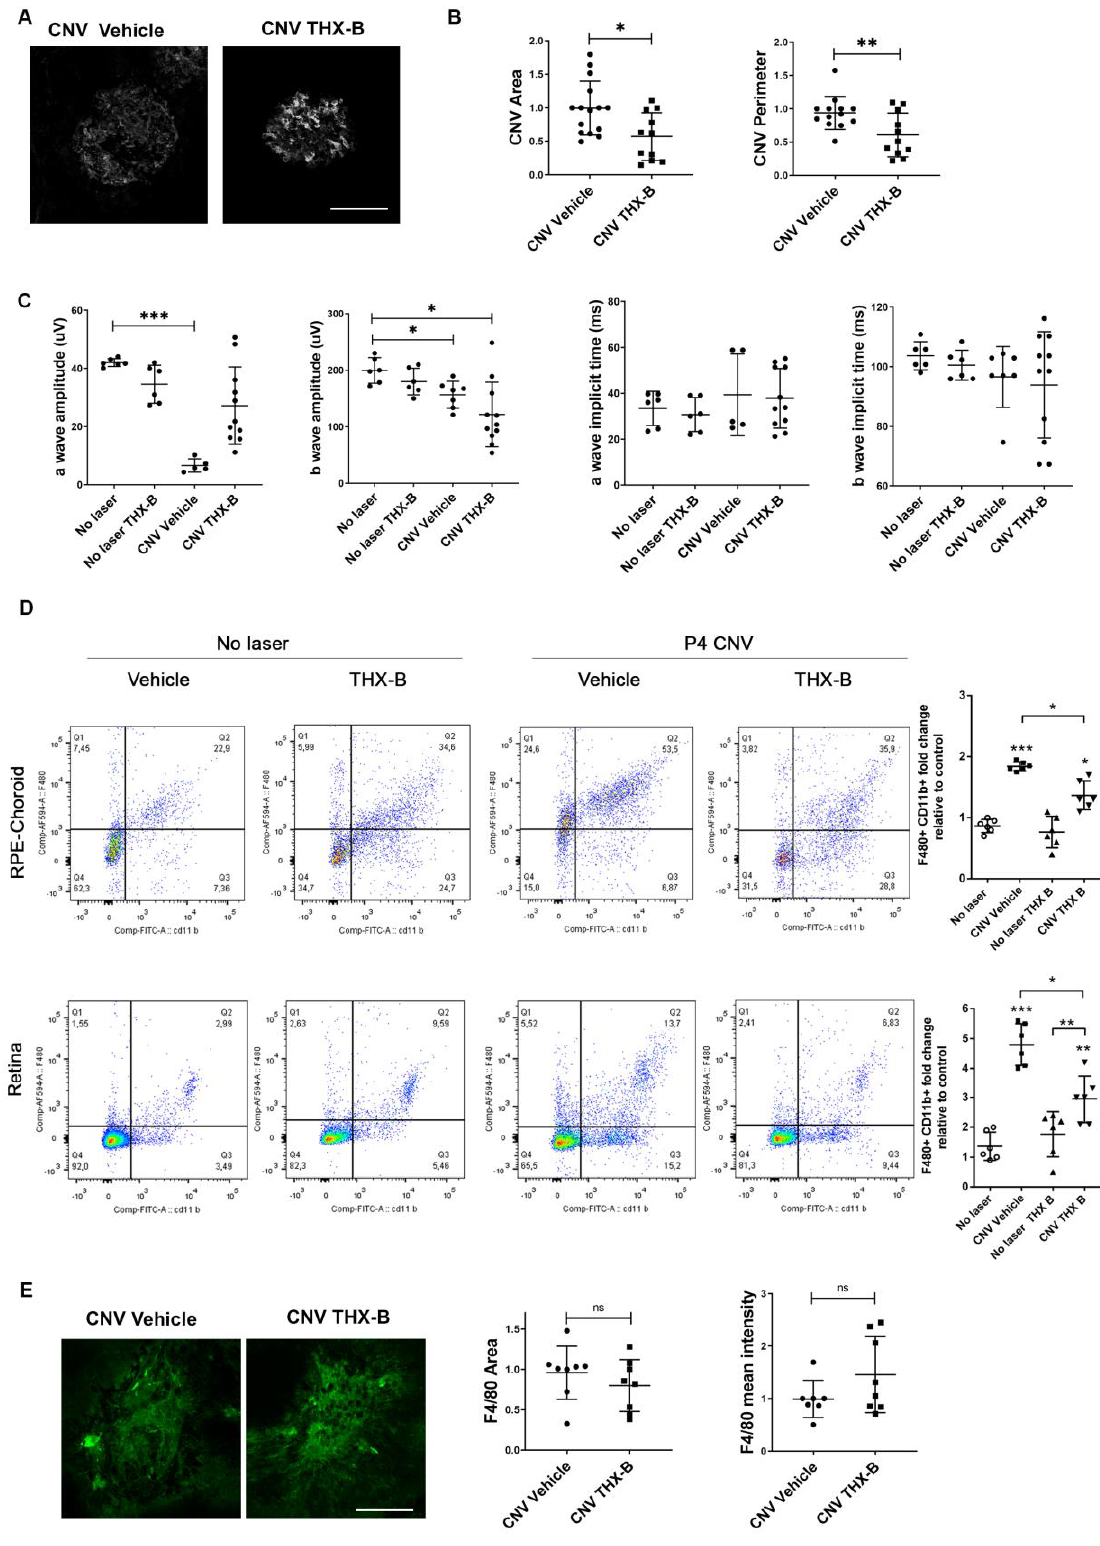
Figure 5. Reduced neovascular phenotype and improved retinal function in p75 NTR antagonist- treated wild type mice after laser injury. p75 NTR receptor antagonist reduced the area and perimeter of choroidal neovessels and improved retinal functionality in WT CNV mice. ( A ) Representative confocal images of RPE-Choroid flat-mounts of WT mice 7 days after laser, showing immunofluorescence staining with Isolectin IB-4 (grey). Scale bar: 100 µ m. ( B ) The area and perimeter of neovessels were quantified with ImageJ FIJI software and represented in the bar graph expressed as units relative